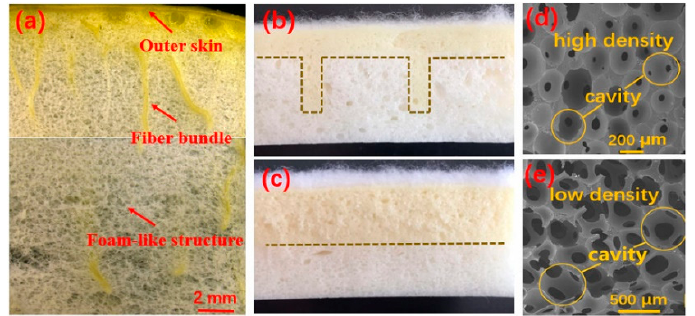
Figure 3. ( a ) Cross section of pomelo peel [21]; ( b ) Cross section of bionic composite with columnar lattice structure; ( c ) Cross section of bionic composite with parallel structure (NPUH-L shows bionic composite with parallel structure); ( d ) Microstructure of high-density polyurethane (PU) foam in upper layer; ( e ) Microstructure of low-density PU foam in lower layer.